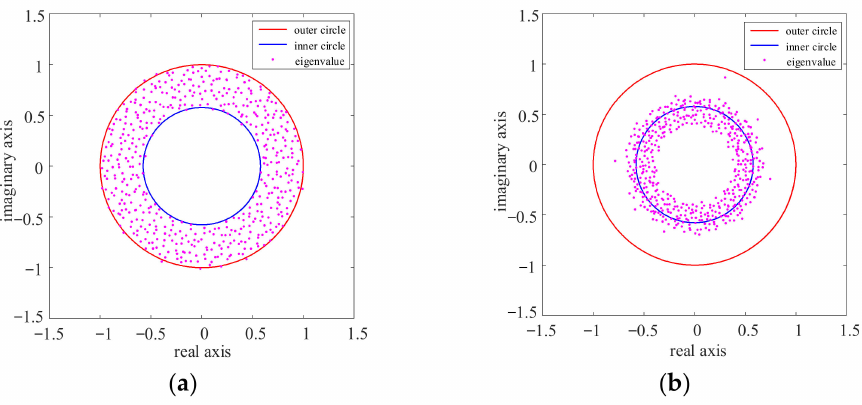
Figure 2. Analytical results of the Ring Law. ( a ) Normal state, ( b ) Abnormal state.